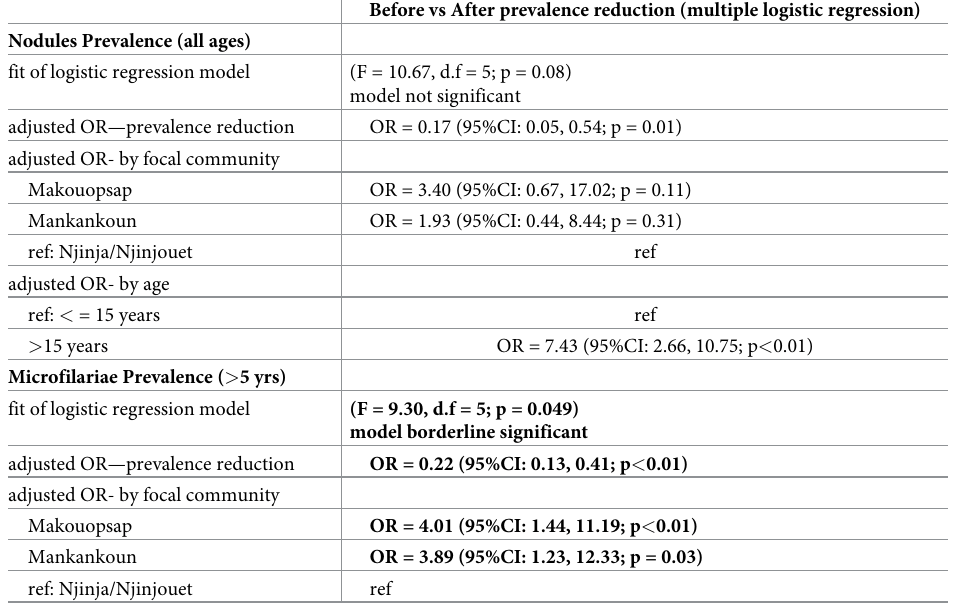
Table 5. Modelling the significance of prevalence reduction from pre- to post-intervention surveys. Before vs After prevalence reduction (multiple logistic regression) Nodules Prevalence (all